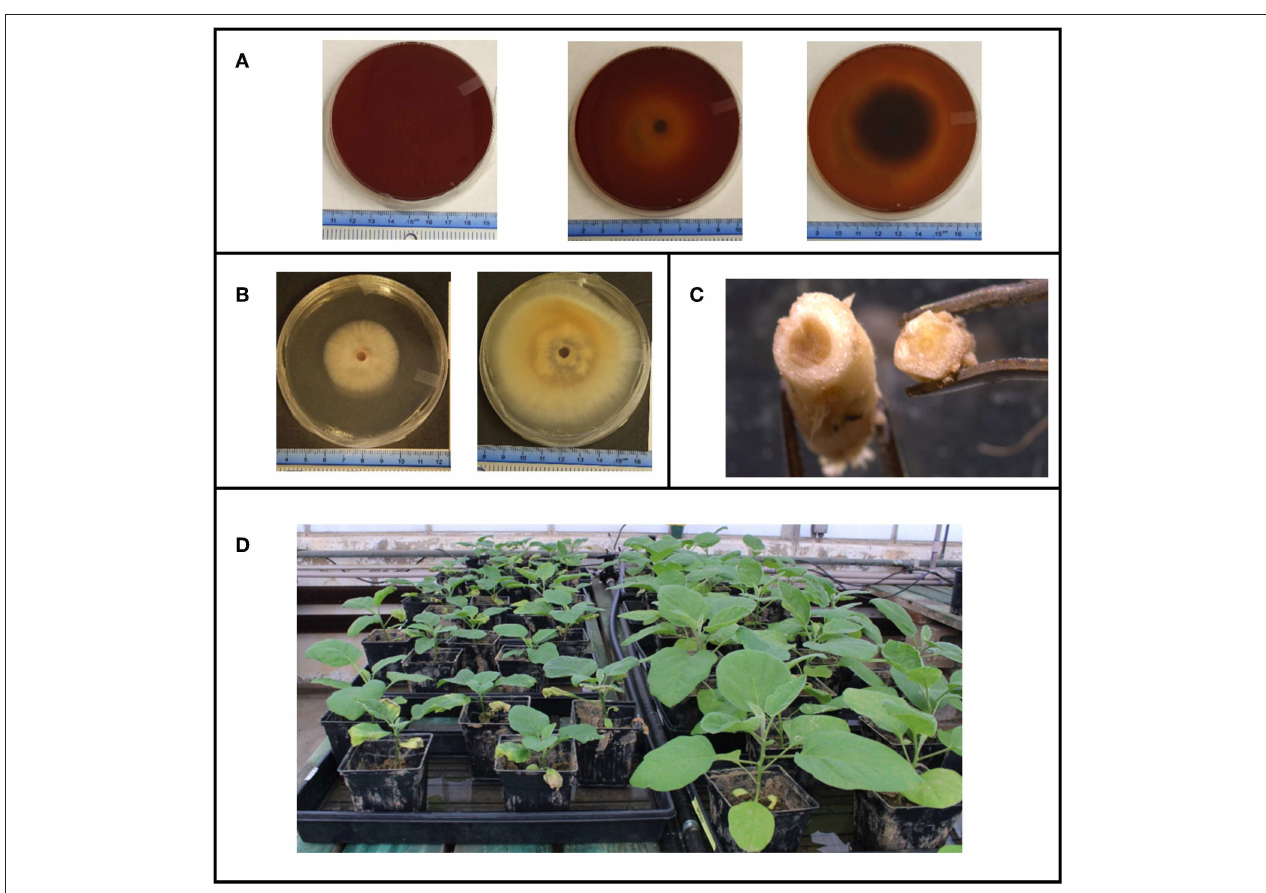
FIGURE 1 | (A) Fusarium oxysporium grown on media containing the pH indicator bromocresol purple to indicate how far beyond the visible mycelial tips, nutrients are being uptaken by the mycelia. (B) Typical growth of Verticillium dahliae on Czepeck dox agar. (C) Stem cross section of eggplants inoculated with V. dahliae (left) and an uninoculated (right). (D) Overall set up of eggplants in the green house with a side by side comparison of inoculated eggplants (left) to uninoculated eggplants